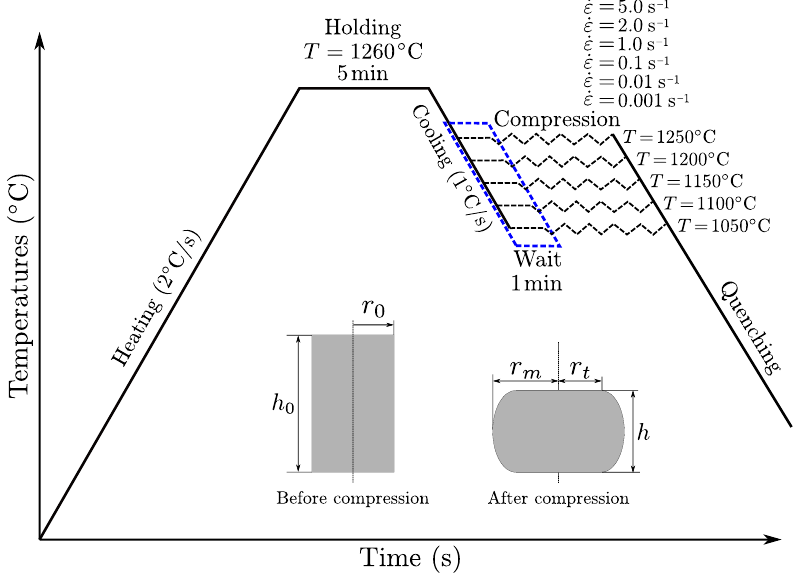
Figure 3. Schematic diagram of the experimental process on the Gleeble-3800 thermomechanical simulator. The stress–strain curves are automatically exported from the Gleeble thermomechan- ical simulator system as the true stress and true strain according to the L-gauge, where the formula to obtain the curves is given by σ = F / A and ε = ln ( 1 + ∆ h / h 0 ) or